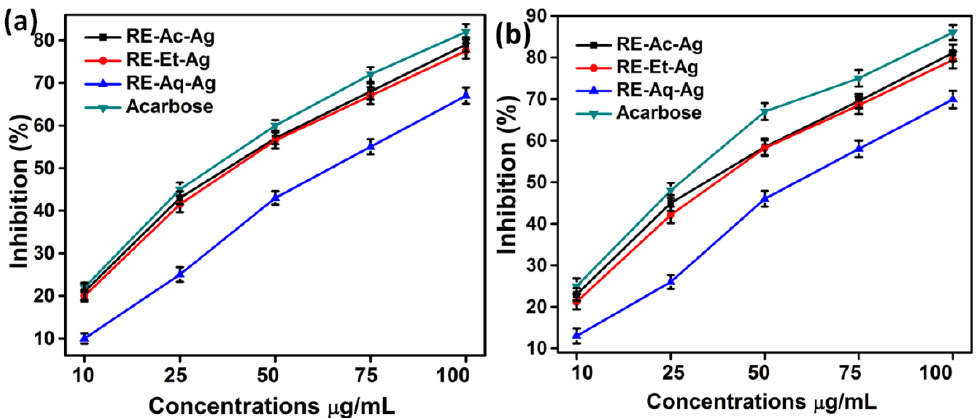
Figure 8. ( a ) Inhibitory effect of α -amylase and ( b ) α -glucosidase at various concentrations of AgNPs (values with mean + SD, n = 3).